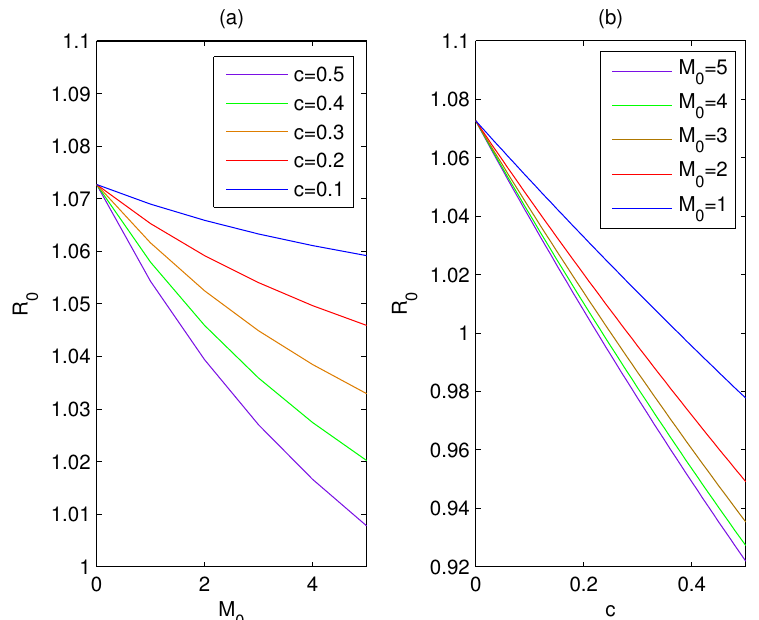
Figure 1. ( a ) Description of basic reproduction number R 0 due to variations of M 0 for different values of c ( c = 0.1,0.2, 0.3,0.4,0.5). ( b ) Description of basic reproduction number R 0 due to variations of c for different values of M 0 ( M 0 = 1,2,3,4,5).